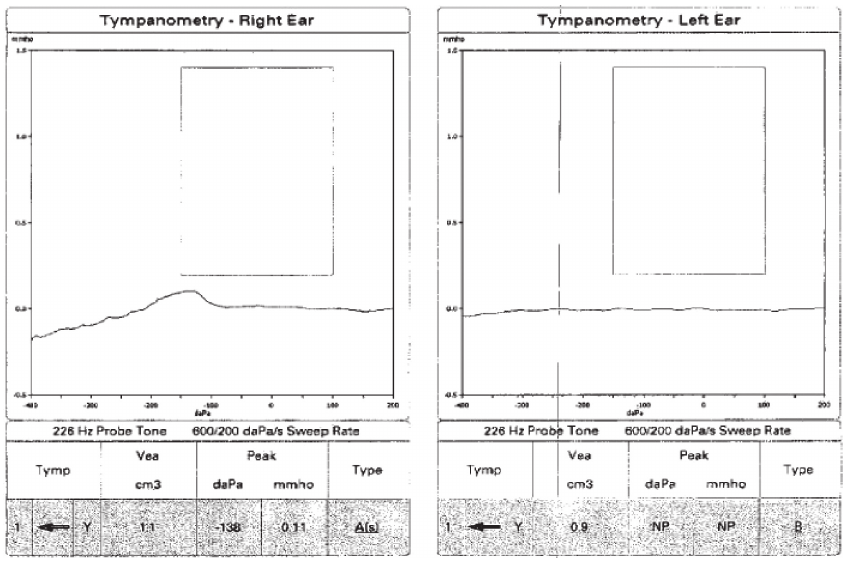
Figure 1: Type As and type B tympanograms in the right and left ear, respectively, upon admission.